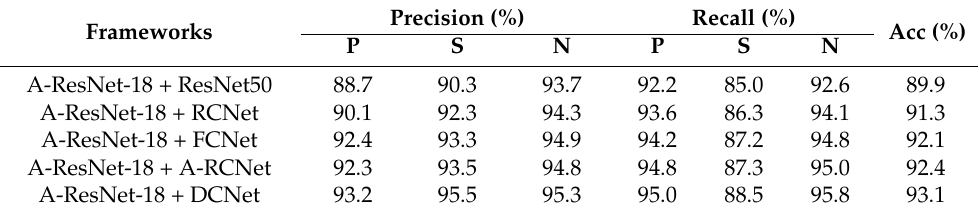
Table 4. Comparison of different frameworks in which A-ResNet-18 is combined with varying detection-classification networks.